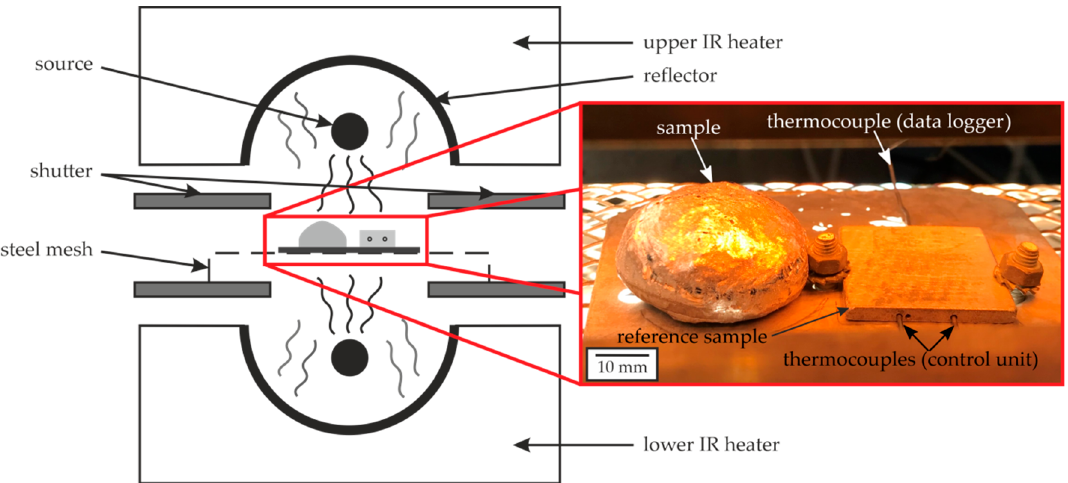
Figure 5. Schematic representation of the heating device used for the foaming experiments and an actual image of a foam sample next to the reference sample used for temperature measurement.